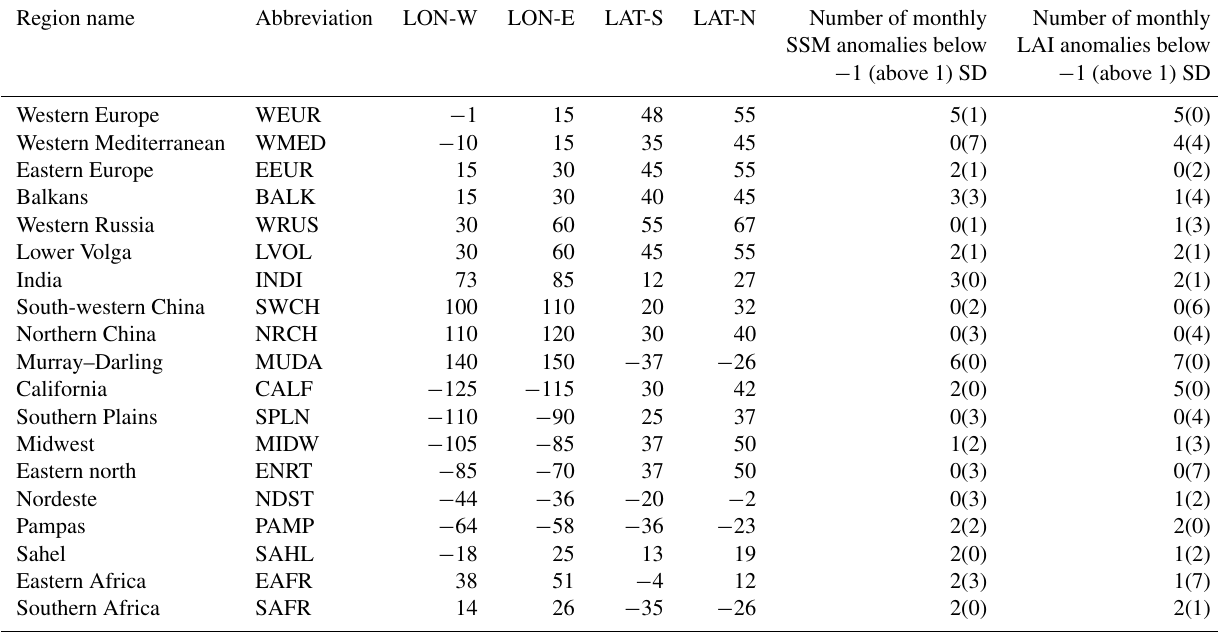
Table 1. Continental hotspots for droughts and heatwaves and number of monthly anomalies SSM and LAI below − 1 standard deviation (SD) and above 1SD in 2018 with respect to the 2010–2018